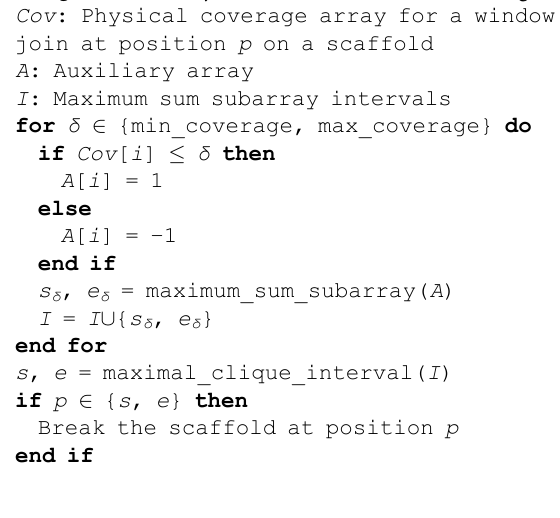
Algorithm 2 Misjoin detection and correction algorithm